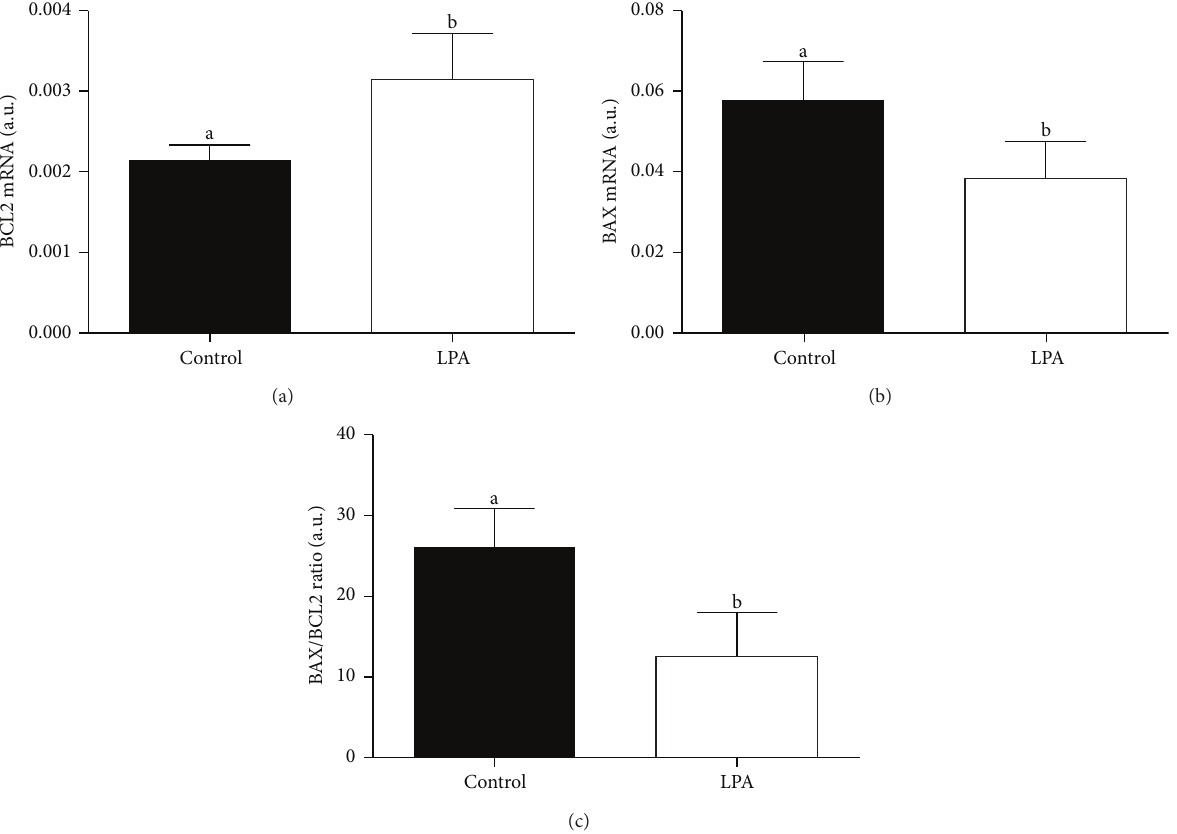
Figure 5: The effect of LPA (10 −5 M) supplementation of maturation medium on mRNA abundance of BCL2 (a), BAX (b), and BAX/BCL2 ratio (c) in oocytes. The values are expressed as mean ± SEM. Different letters indicate significant differences ( 𝑃 < 0.05 ), as determined by Student’s 𝑡